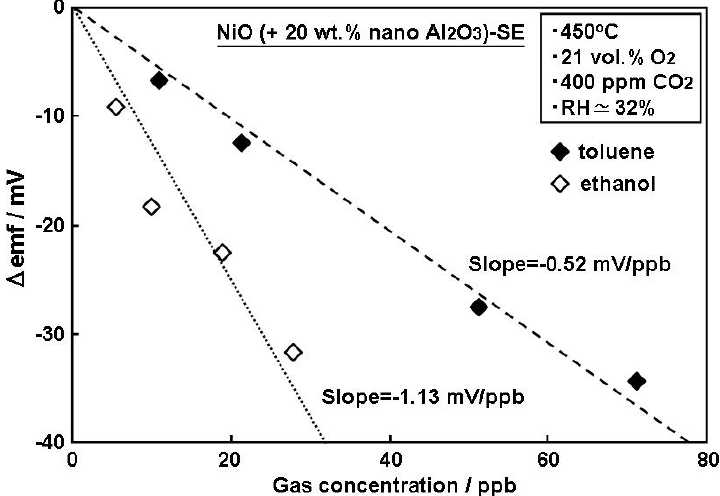
Figure 3. Calibration curves of YSZ-based sensor utilizing NiO(+Al toluene and ethanol at an operational temperature of 450 °C under humid conditions (RH ⋍ 32%).